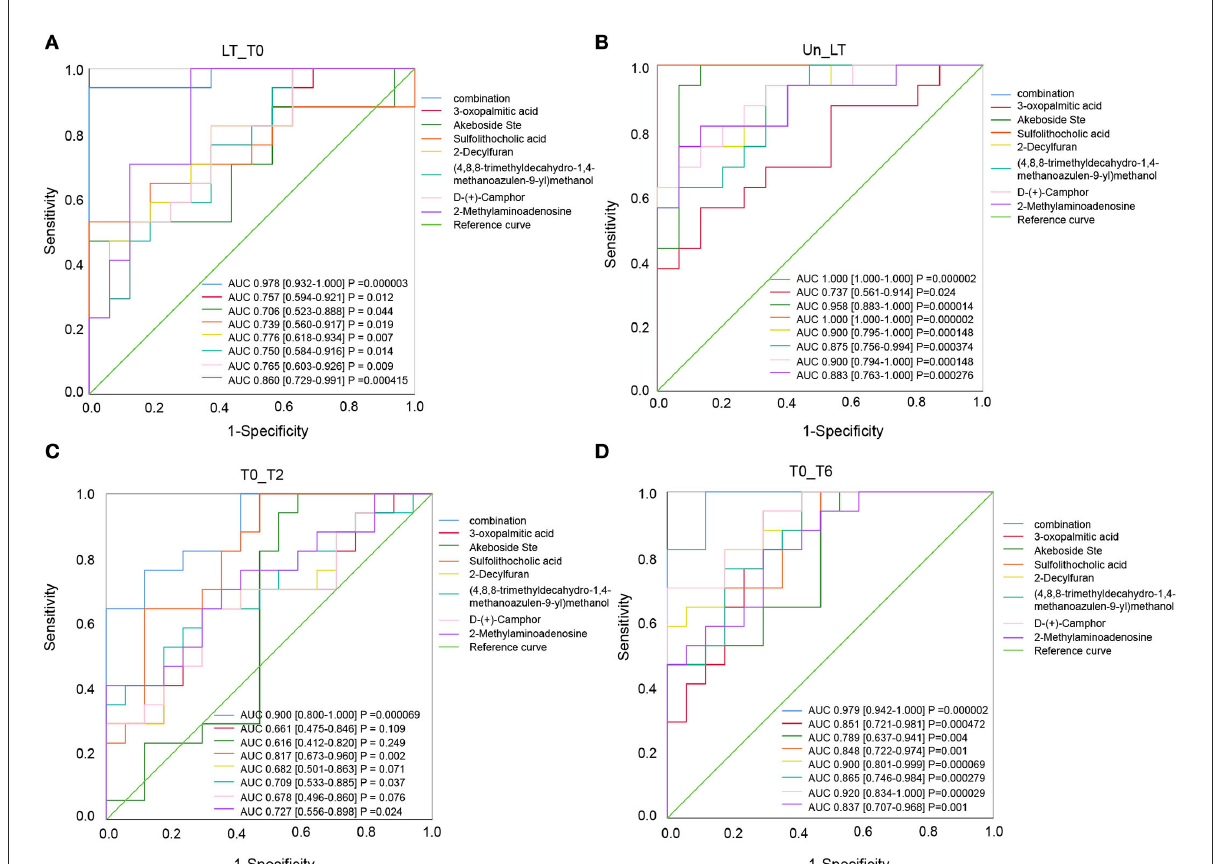
FIGURE4 ROC curves are used to identify differential metabolites. The curve analysis of the seven metabolites shows that the combined diagnostic model performed well in distinguishing LT from T0 (AUC = 0.978) (A) and Un (AUC = 1.000) (B) . Compared with group T2 (C) , the combined diagnostic model could better distinguish T0 from T6 (AUC = 0.979) (D)